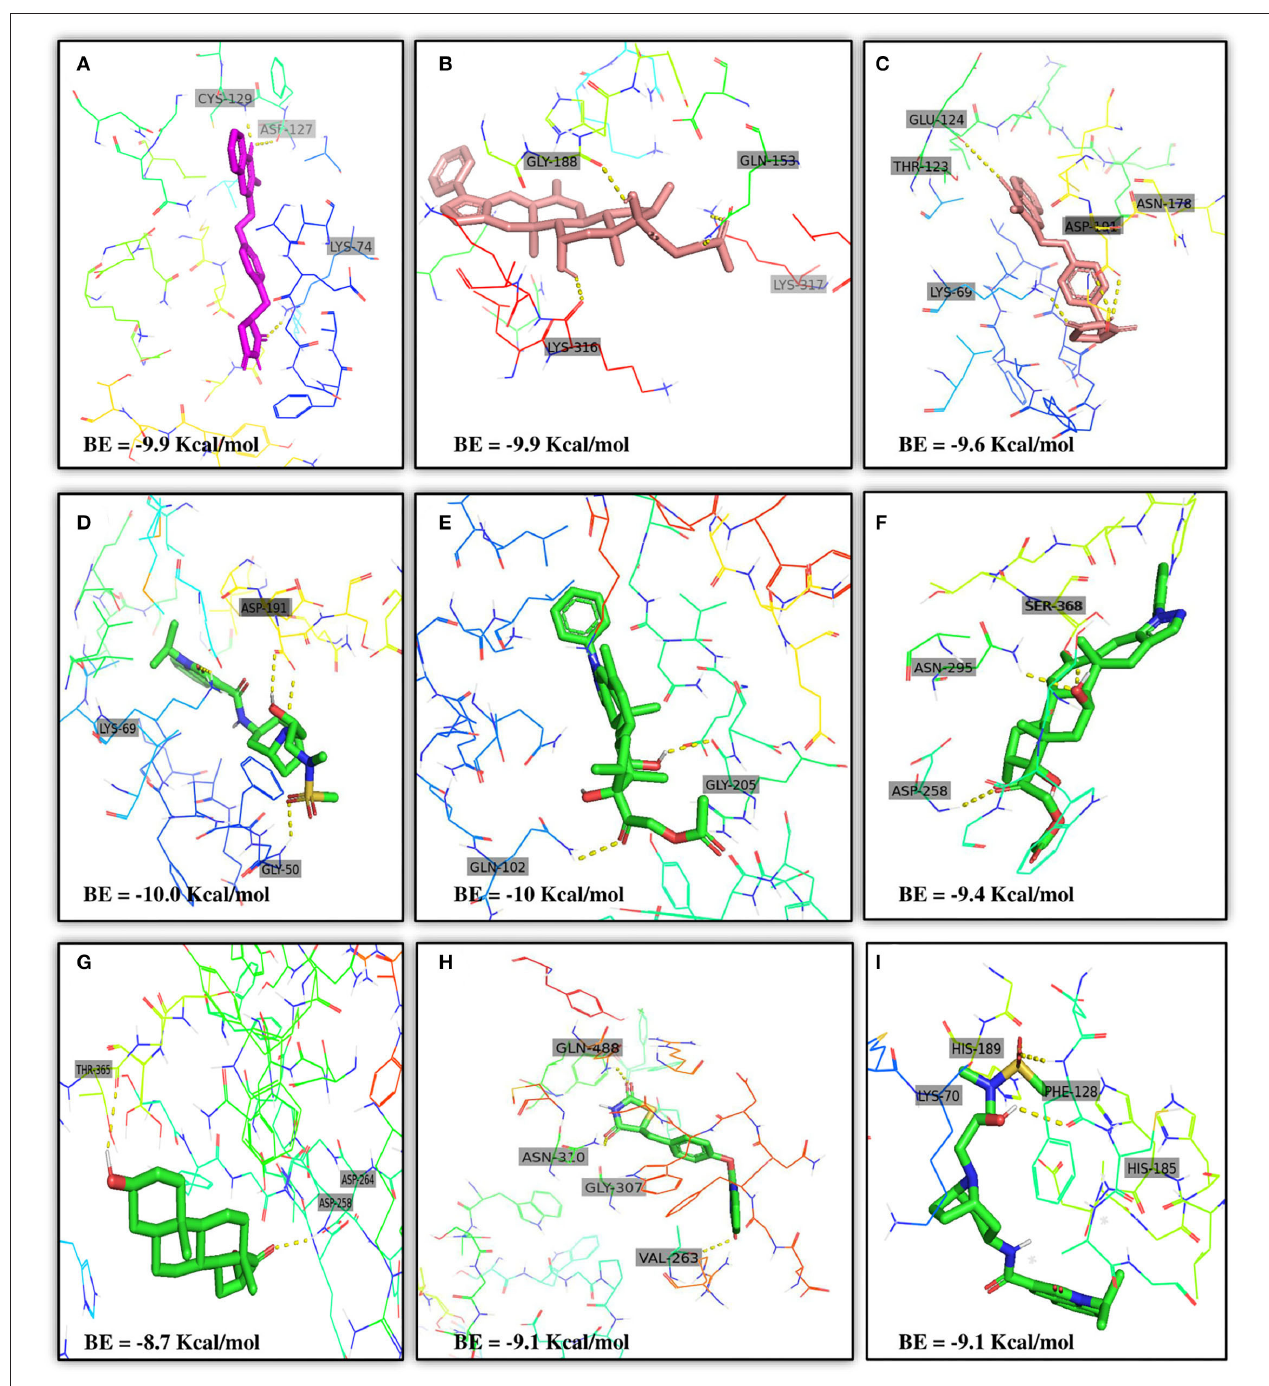
FIGURE 5 | Results of the molecular docking of the potential predicted drugs. Further, it shows the molecular interaction, residues, and scores. (A,B) It shows the interaction of Adaptor Protein 2-Associated Kinase 1 (AAK1) with Balaglitazone, Cortivazol, and Velusetrag, respectively. The docking score of the small molecules is 9.9 for the first two and 19.1 for Velusetrag which suggests strong binding affinity during the interaction. Additionally, in (C,D) interaction of Cyclin-G-associated − − kinase with Balaglitazone and Velusetrag is shown, respectively, with docking scores of 9.6 and 10.0. Whereas (E) , shows the molecular interaction between − − Angiotensin-converting enzyme 2 (ACE2) and Cortivazol with a docking score of 10 followed by (F–H) Cortivazol, 16 alpha-Bromoepiandrosterone, and − Balaglitazone results with Furin. The docking score for Furin-Cortivazol complex is 9.4, for Furin-16 alpha-Bromoepiandrosterone, the docking score is − Furin-Balaglitazone, the docking score is 9.1. (I) Cortivazol binding affinity with Adaptor Protein 2-Associated Kinase 1 (AAK1). −